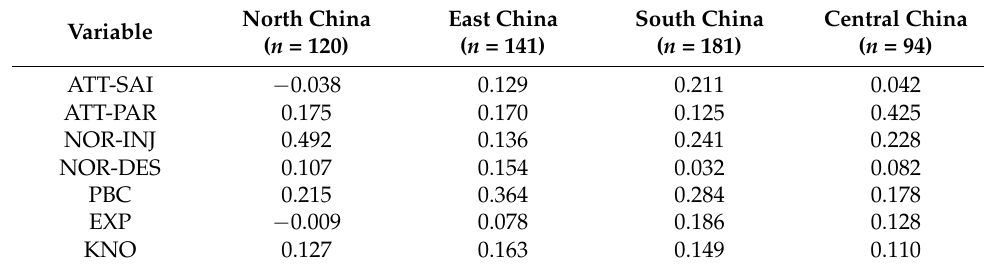
Table A4. Absolute differences in path coefficients by region.